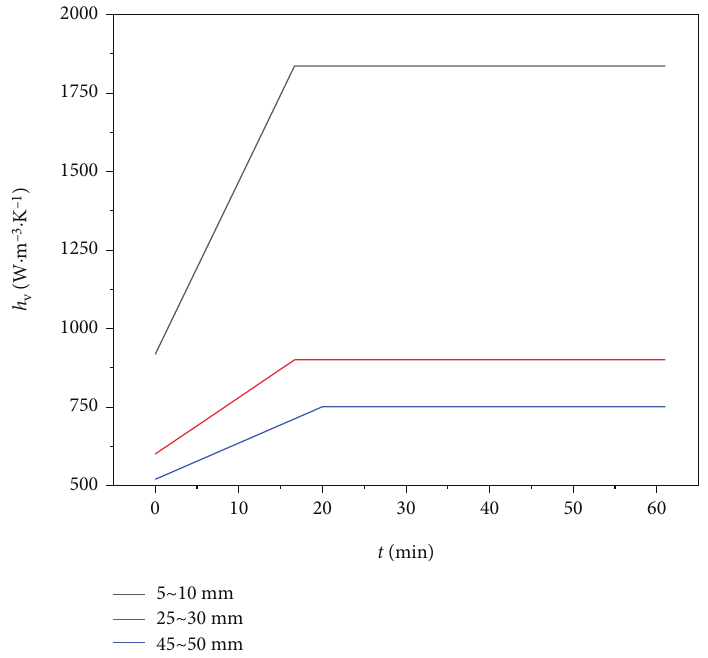
Figure 9: Volumetric heat transfer coe ffi cients h